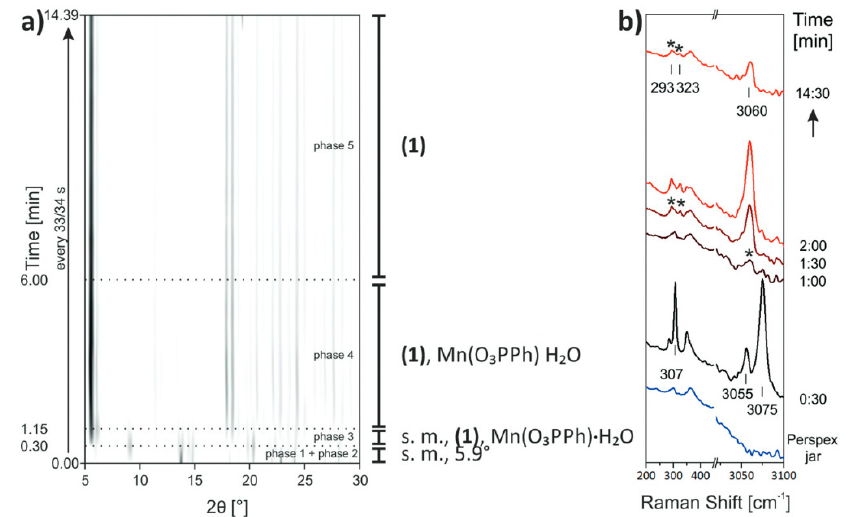
Figure 21. Two-dimensional (2D) plots of ( a ) synchrotron X-ray diffraction (XRD) data with a description of the detected compounds and ( b ) in situ Raman spectroscopy measurements monitoring the synthesis of Mn(HO 3 PPh) 2 (H 2 O 3 PPh) 2 (H 2 O) 2 . Adapted with permission from reference. [57]. Copyright 2016, Royal Society of Chemistry.